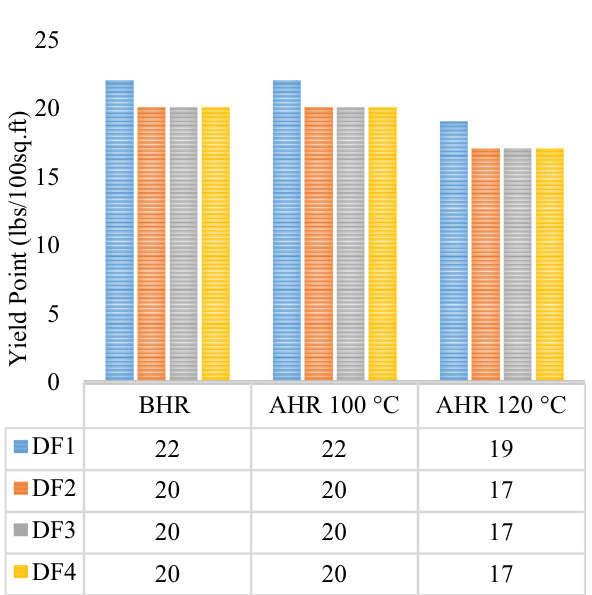
Fig. 7 Variation of YP after hot rolling